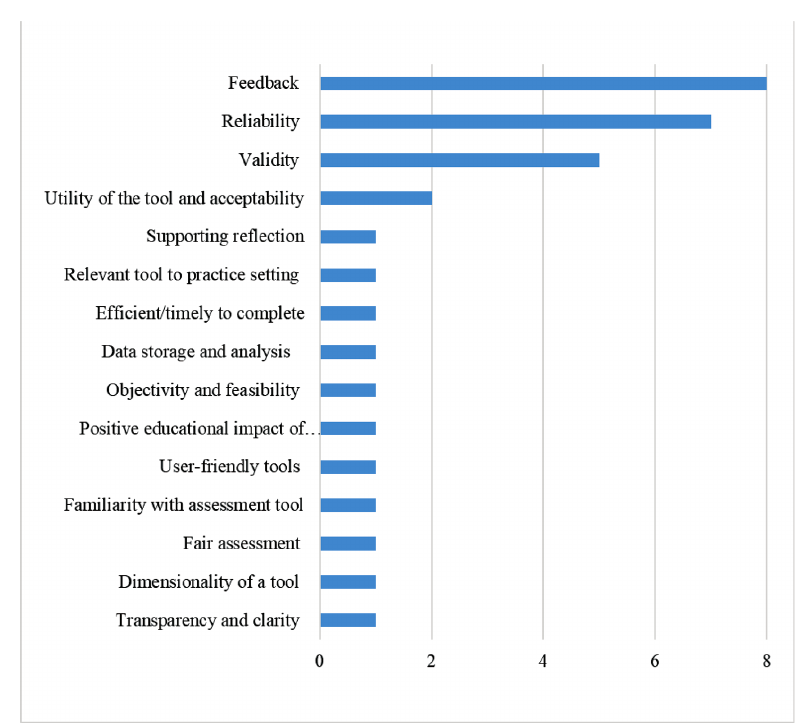
Table 2. Clinical competency assessment systems/tools/frameworks/models.